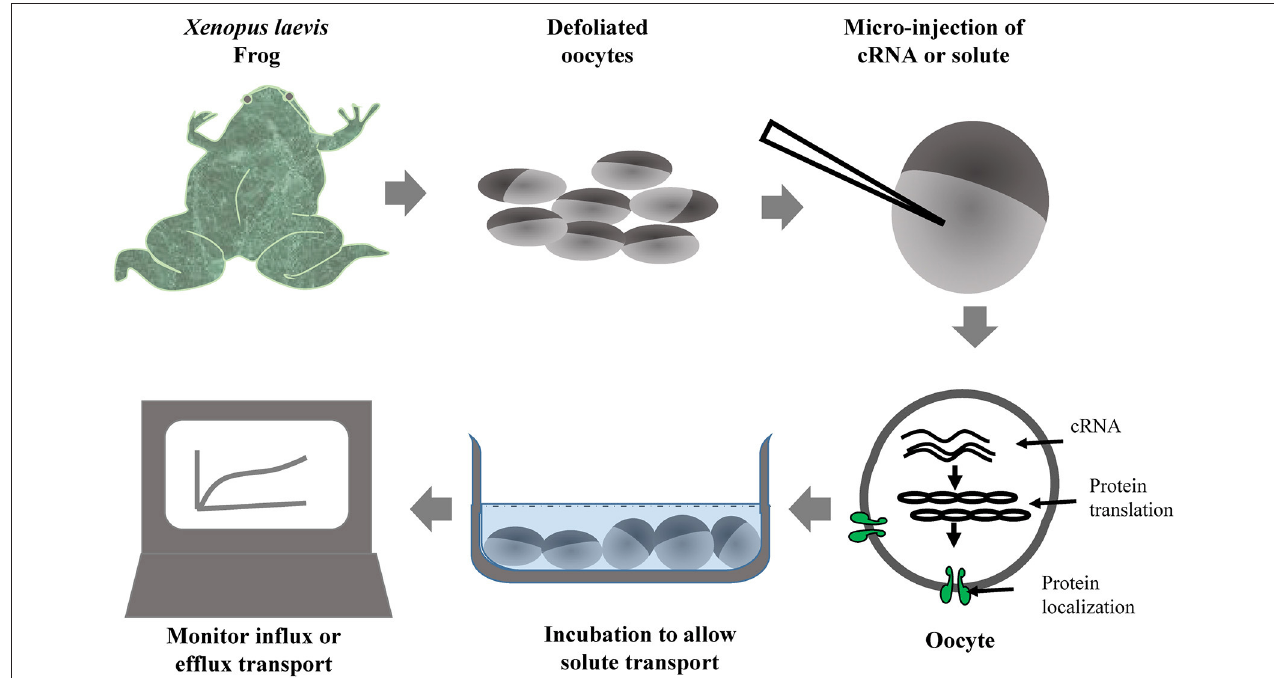
FIGURE 2 | Simplified workflow of Xenopus oocyte assay used for the evaluation of solute transport by heterologously expressed foreign transporters including aquaporins.